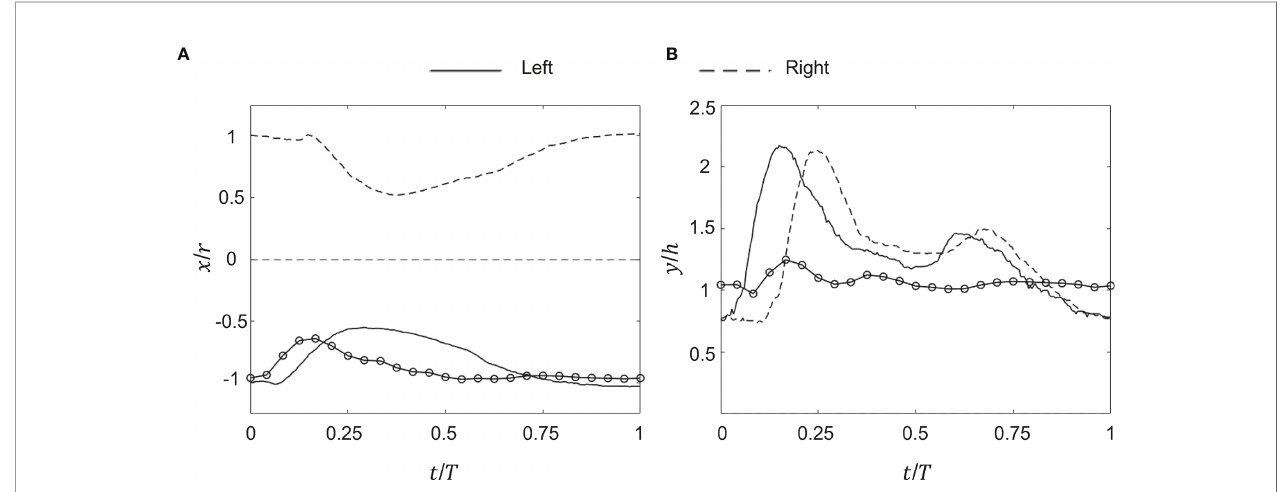
FIGURE 4 | Kinematics of the medusa bell margin tip. (A) Non-dimensional horizontal displacement versus non-dimensional time ( t / T ). x / r is the ratio of bell margin tip displacement in the horizontal ( x ) direction to the bell radius ( r ). T is the time period of a bell pulsation cycle. (B) Non-dimensional vertical displacement versus t / T . y / h is the ratio of bell margin tip displacement in the vertical ( y ) direction to the bell height ( h ). Lines without markers correspond to experimental measurements on a live medusa, while lines with markers are from numerical simulations. Kinematics of the bell margin tip extracted from experimental data are shown for both the left side (solid lines) and right side (dashed lines), de fi ned relative to the oral-aboral axis ( x , z ) = (0,0). Kinematics obtained from the numerical bell model were only tracked on the left side of the bell margin. r = 20 mm, h = 4 mm and T = 1.18 s were used to non-dimensionalize experimental data. r = 25 mm, h = 10 mm and T = 1.25 s were used to non-dimensionalize numerical